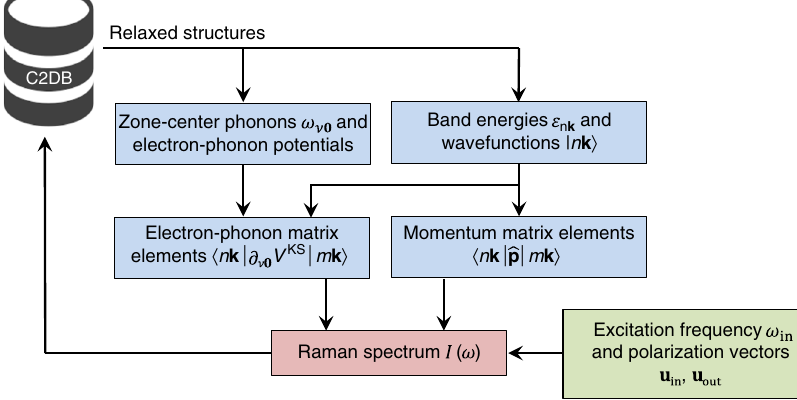
Fig. 2 Computational work fl ow. The diagram illustrates the steps necessary to calculate the Raman tensor of a material.